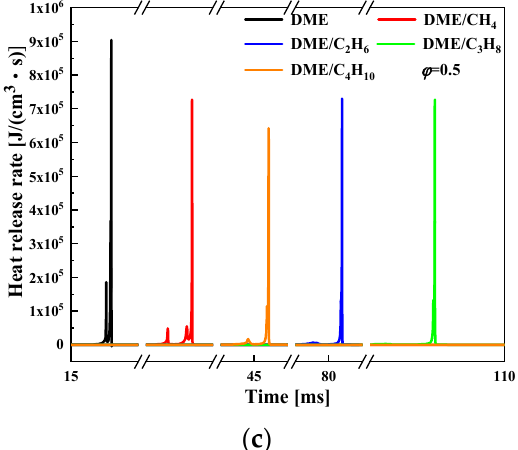
Figure 10. Comparison of heat release rate of DME/C1-C4 alkane mixtures for various equivalence ratios at T c = 650 K and P c = 20 bar: ( a ) φ = 0.3; ( b ) φ = 0.4; and ( c ) φ = 0.5.